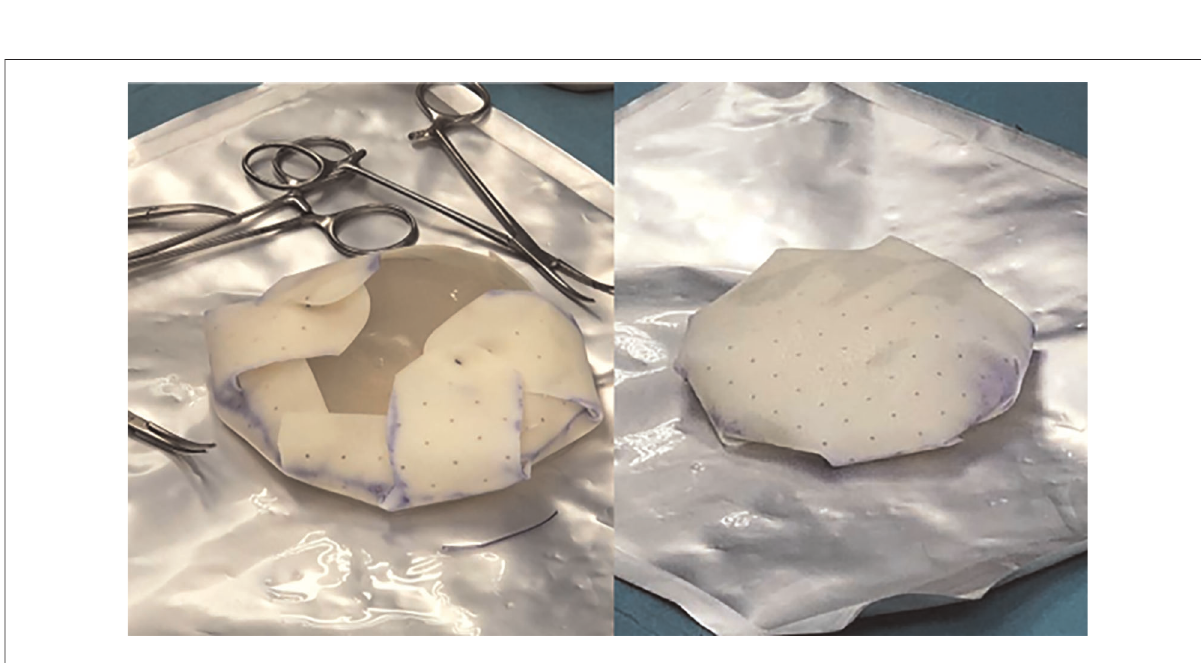
FIGURE 5 Prosthesis wrapped in ADM ready for